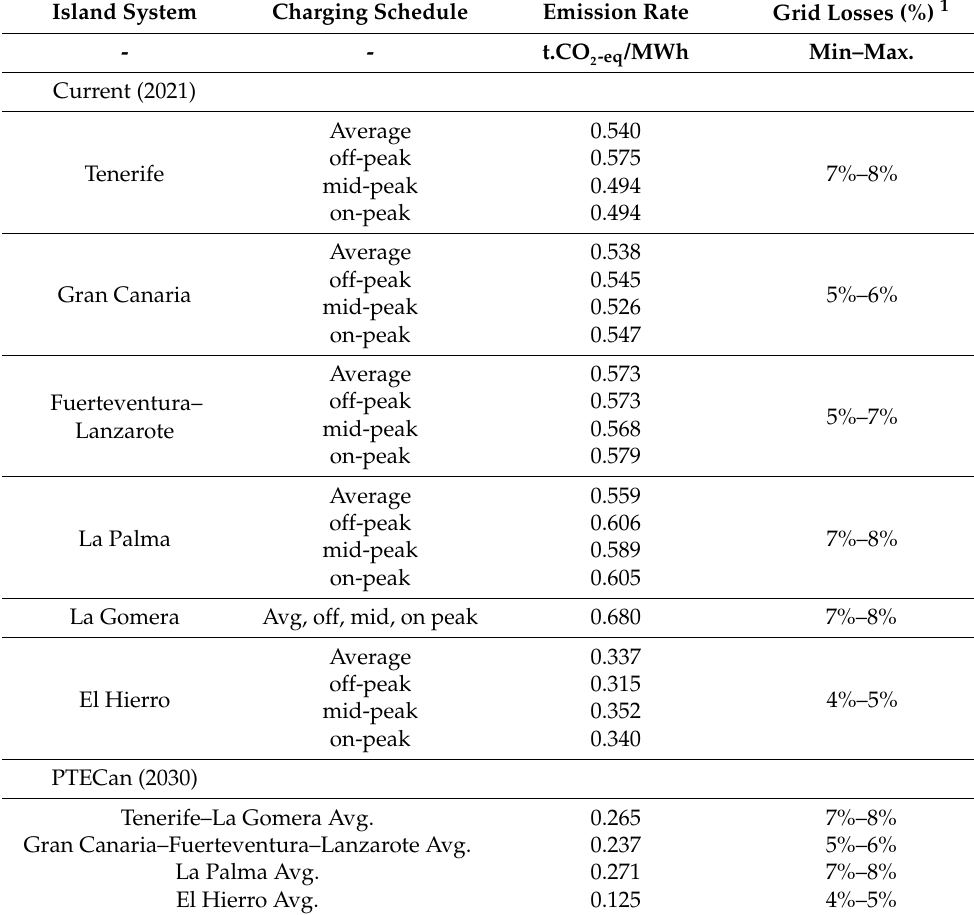
Table 3. Emission rate by system and the electricity grid losses from the power station to the plug. Island System Charging